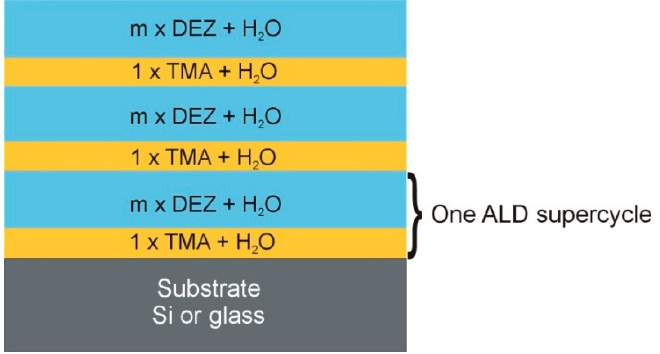
Figure 1. Doping procedure used in ALD technology to obtain AZO films. ALD “supercycle” was repeated to obtain films with about 200 nm